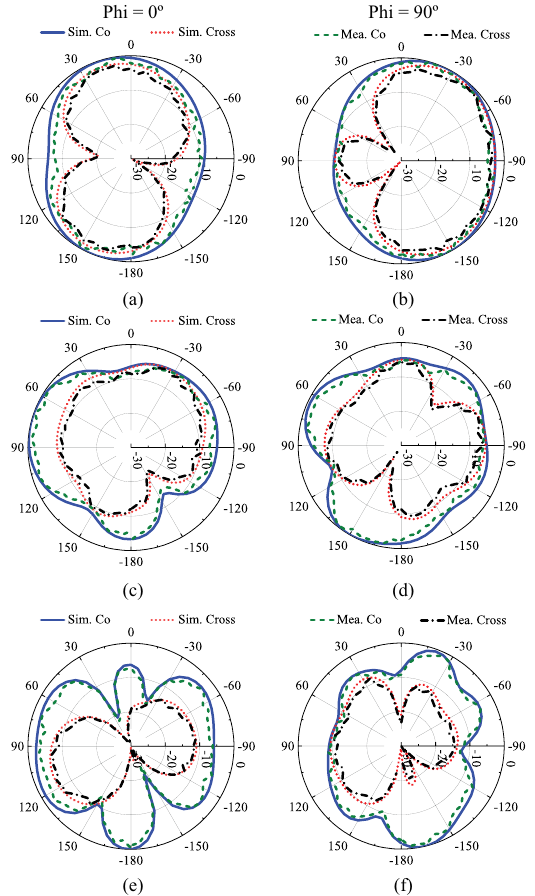
FIGURE 10: Simulated and measured 2D radiation patterns of the proposed array at: (a) 1.50 GHz (b) 3.10 GHz and (c) 4.20 GHz.